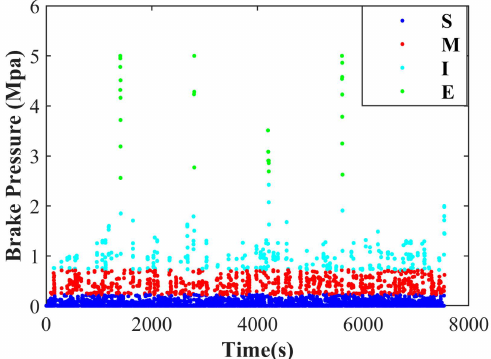
Figure 4. Labeling results of di ff erent brake intentions. Figure 5 randomly captures a window of probabilities of 20 data sets. The green, blue, black, and red circles represent the probabilities of slight, medium, intensive, and emergency brake, respectively.